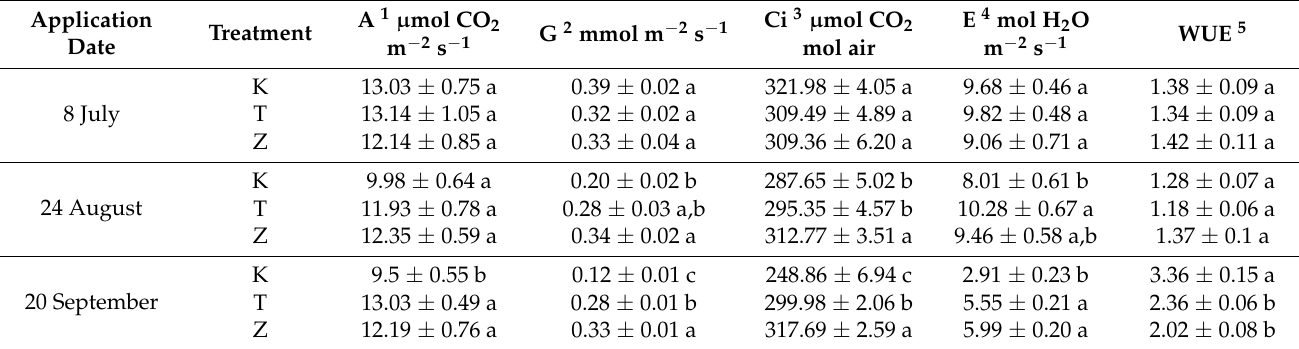
Table 2. Ecophysiological parameters measured after each foliar application of K (kaolin), Z (CHA-zeolitite), and T (control). Data are presented as mean ± standard deviation. Different letters (a,b,c) indicate significant differences according to ANOVA and Tukey’s HSD test ( p < 0.05) at each application